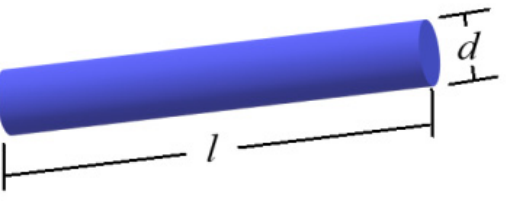
Figure 1. Schematic of a particle.